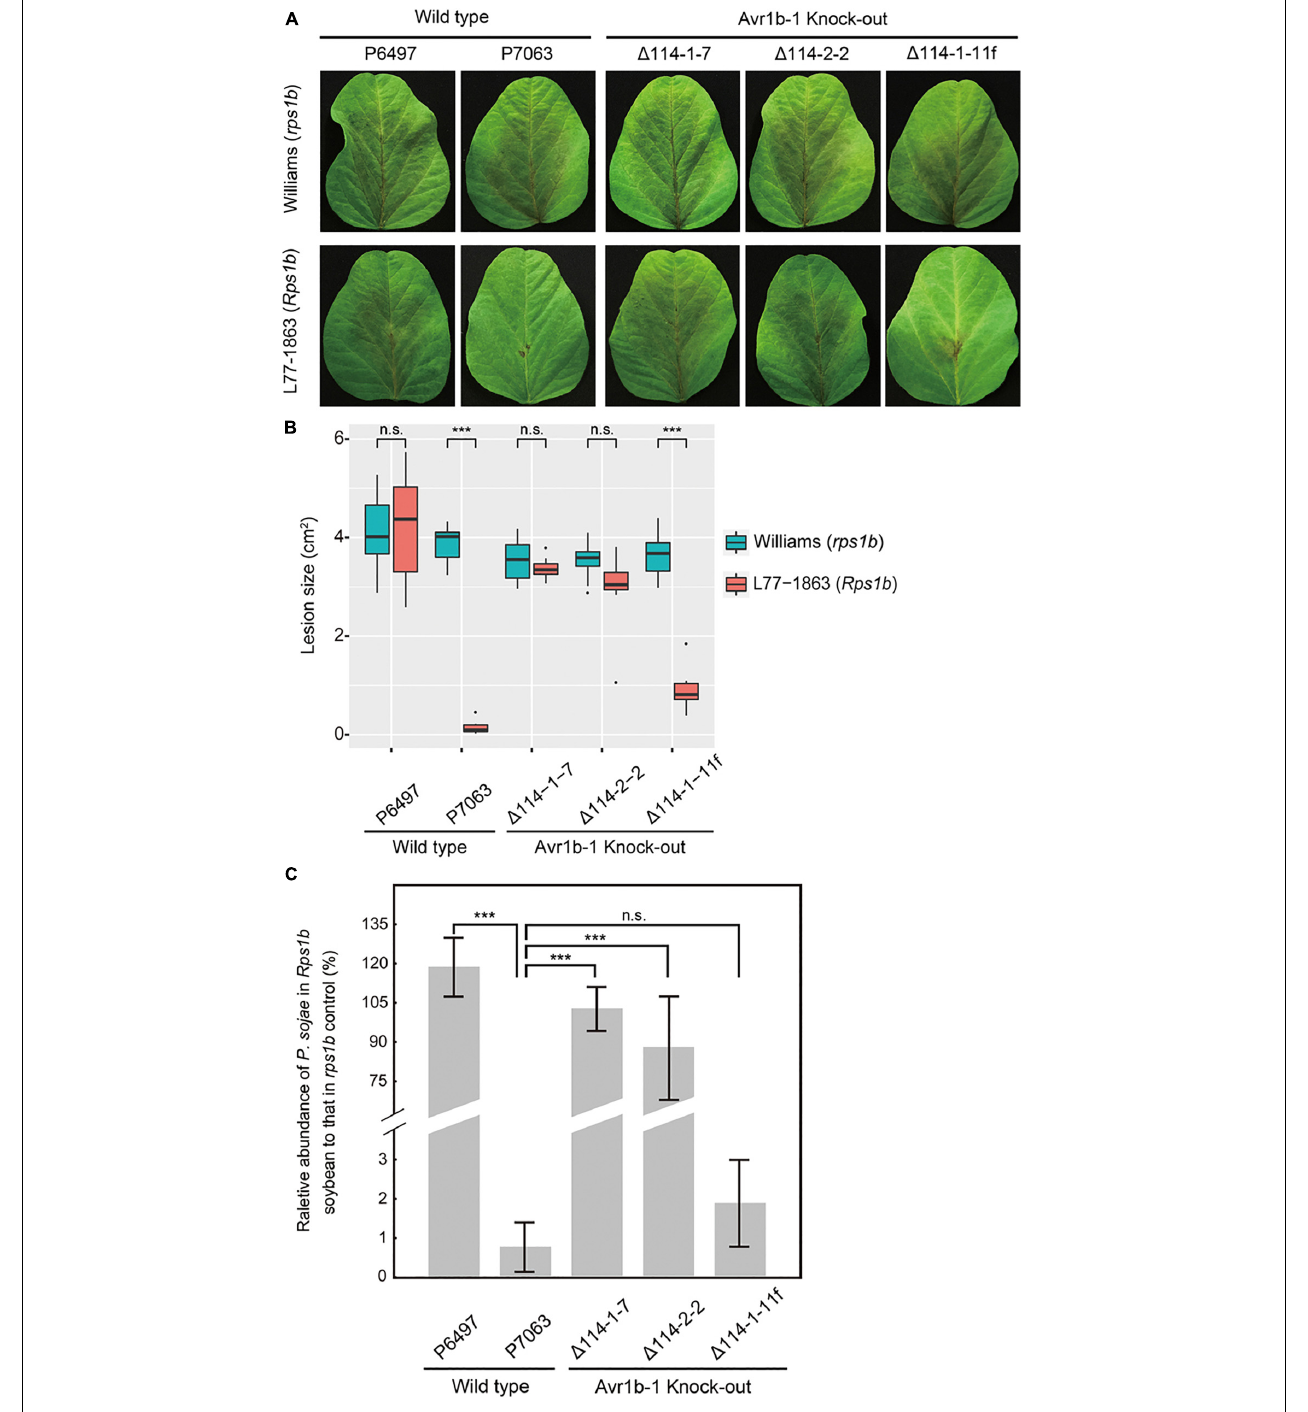
FIGURE 2 | Avirulence phenotypes of Avr1b-1 knock-out transformants measured by detached leaf inoculations. (A) Soybean leaf lesions 3 days after zoospore inoculation of Williams ( rps ) or L77-1863 ( Rps1b ) unifoliate leaves. (B) Sizes of lesions after 3 days. Lesions on eight unifoliate leaves were measured in each of three independent experiments. The relative lesion size was measured from photographs with ImageJ software. Lesion sizes were compared between Williams ( rps ) and L77-1863 ( Rps1b ) using the Wilcoxon rank sum test. *** P < 0.001, n.s. P > 0.1. (C) Avirulence phenotypes of Avr1b-1 knock-out transformants measured by real-time PCR-based quantification of P. sojae genomic DNA in infected tissue. Proliferation of P. sojae was plotted as the ratio between the abundance of PsActin relative to GmActin DNA in infected L77-1863 leaves compared with that in infected Williams leaves, at 72 hpi. Error bars represent standard deviation of three technical replicates. This experiment was replicated three times. Error bars represent the mean ± standard deviation. P -values were determined by the Wilcoxon rank sum test; *** indicates P < 0.001.